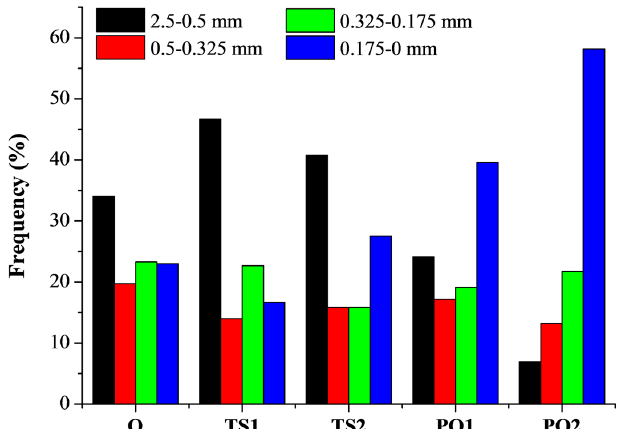
Figure 4. Fiber length distribution of fibers extracted from pulp fiber/HDPE composites. Composite O: wet pulp fiber/HDPE mixture was dried by oven. Composite TS1: wet pulp fiber/HDPE mixture was dried by twin-screw extruder. Composite TS2: mixture TS1 was melt-extruded again. Composite PO1: